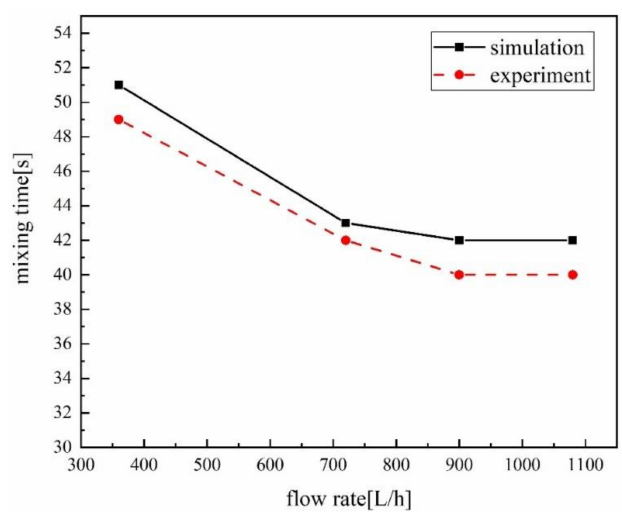
Figure 8. Experimental and numerical mixing time at different gas injection flow rate.